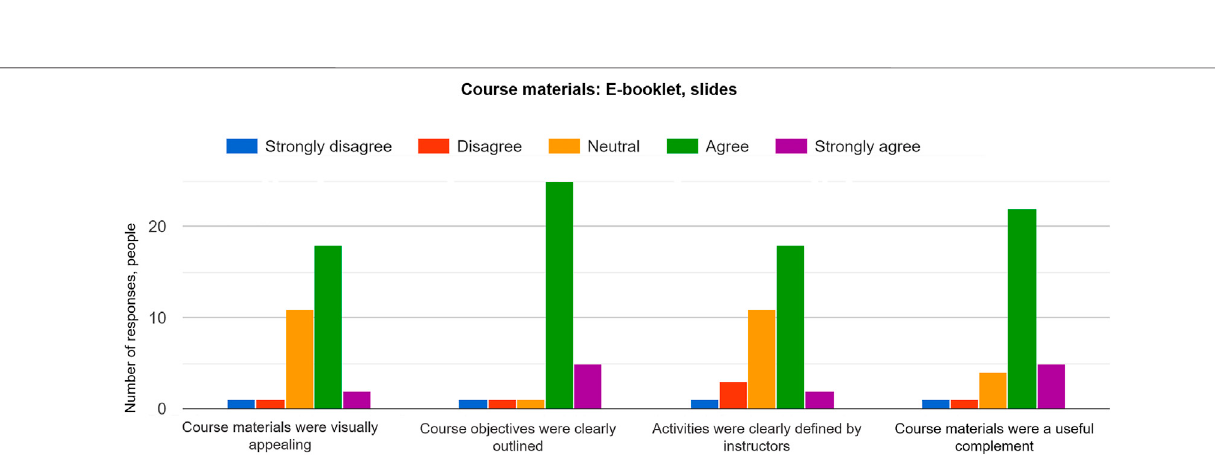
Frontiers in Earth Science |